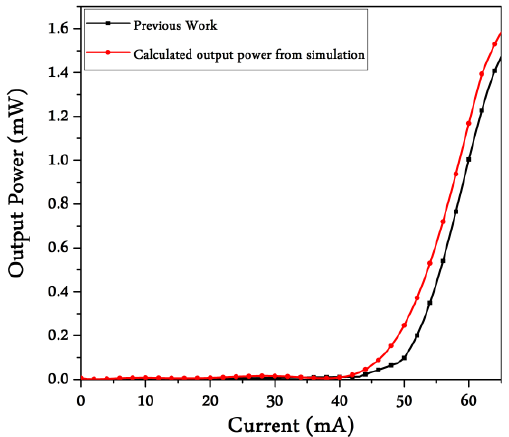
Figure 16. Comparison of output power vs. current curve for InGaN/GaN QW-based green laser (λ = 525.5 nm) calculated by our simulation model on semipolar (202 ̅ 1)-oriented GaN substrate with the results reported in [39]. The QW is along (1 ̅ 014) orientation.